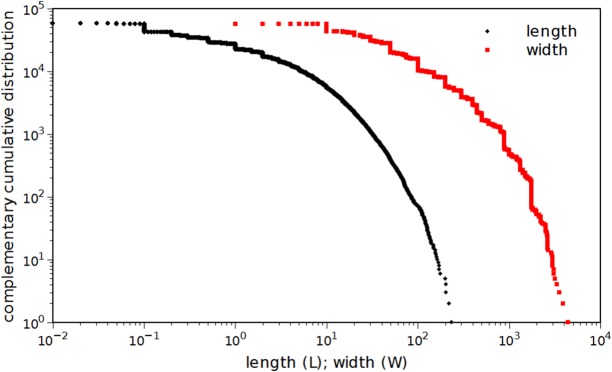
Complementary cumulative distribution of tornadoes path length, L, and width, W.All reported tornadoes that occurred in the U.S., during the time period 1950–2013 are considered.